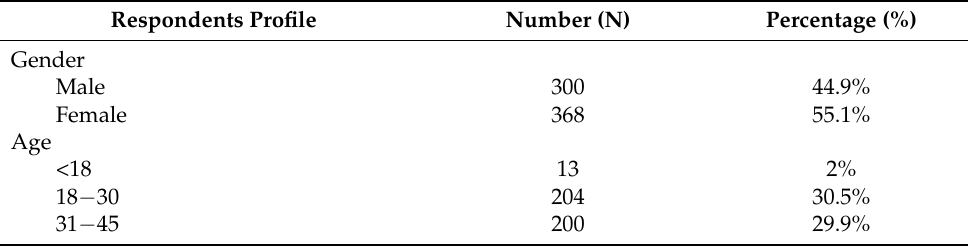
Table 1. Demographic background of the respondents (N =